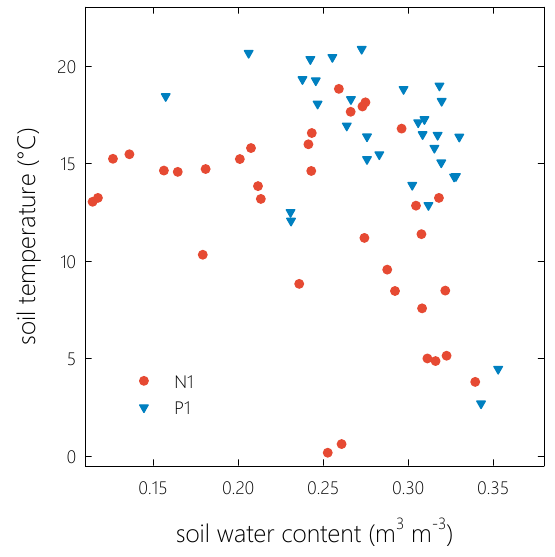
Figure 9. Daily average values of soil temperature ( T soil ) and soil water content (SWC) in two groups defined by the direc- tion of correlation and goodness of fit between half-hourly ac- etaldehyde VMRs and fluxes, where N1...negative slope, r 2 > 0 . 2, P1...positive slope, r 2 > 0 . 2. All management data were excluded from the